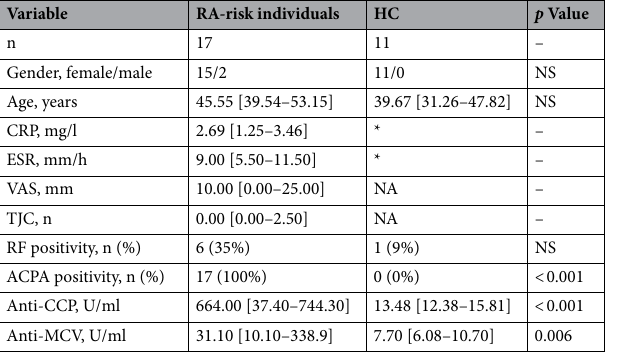
Table 2. Clinical characteristics of ACPA-positive individuals with arthralgia at risk of RA and healthy controls (Phase II).